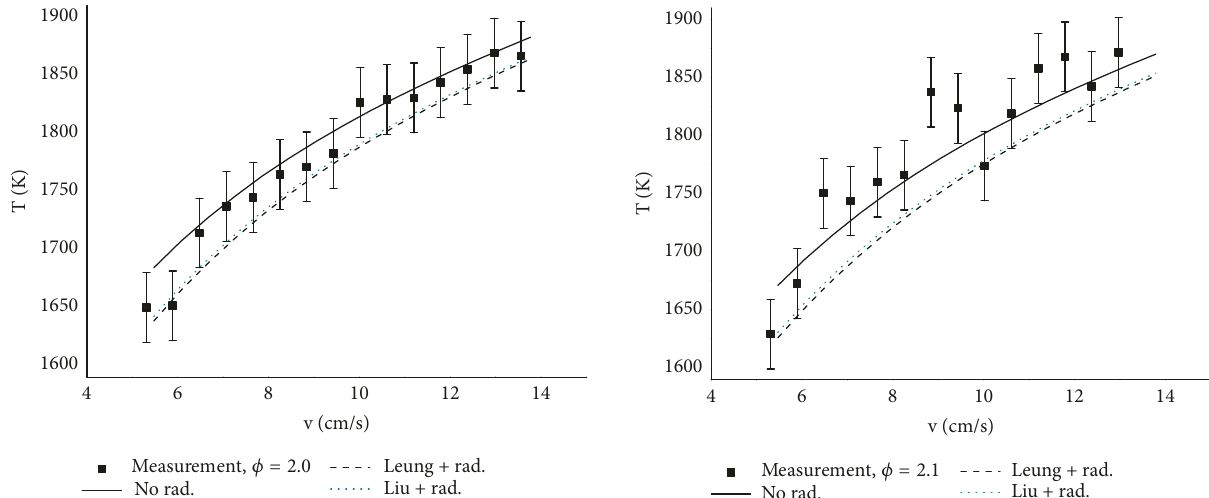
Figure 4: Comparison of calculated (with and without radiative heat losses) and measured flame temperatures for 𝜑 = 2.0 and 𝜙 = 2.1 as a function of exit velocity at HAB = 5